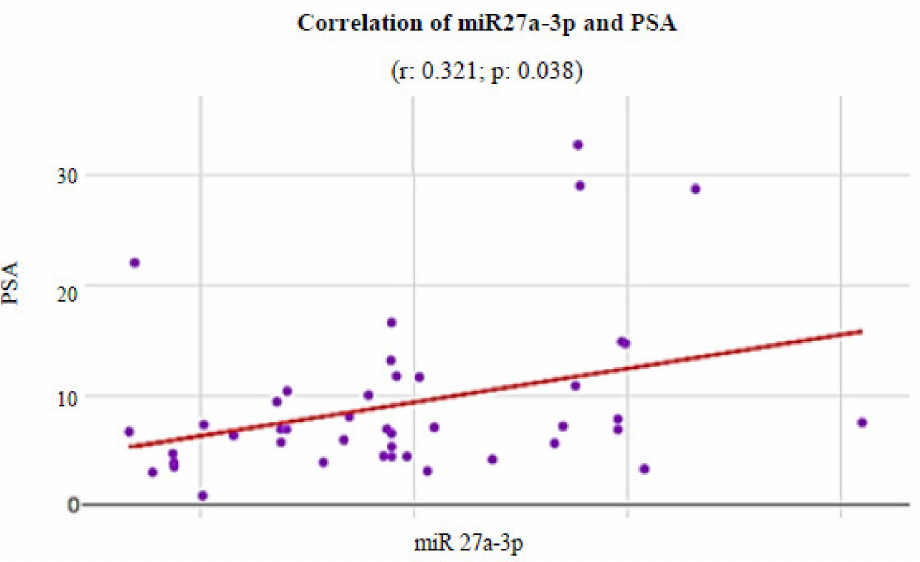
Figure 6. Correlation of PSA levels with the relative prostatic levels of miR27a-3p in the CaP patients: correlation coeficient; p : p value correlation. The Y-axis represents blood PSA levels and the X-axis represents the expression of miRNA by the Western blotting